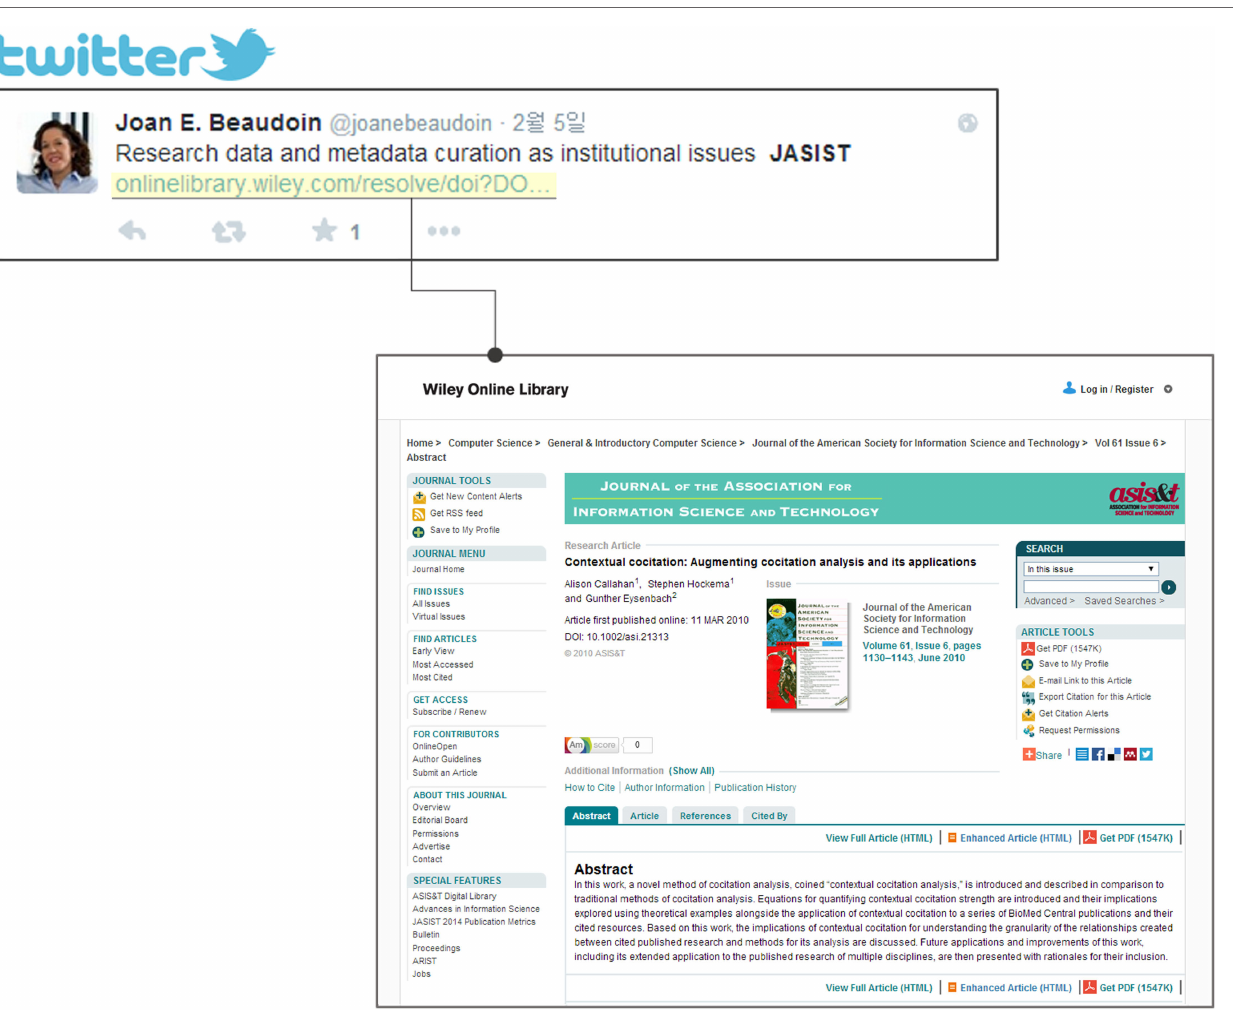
FigUre 1 | Twitter citation